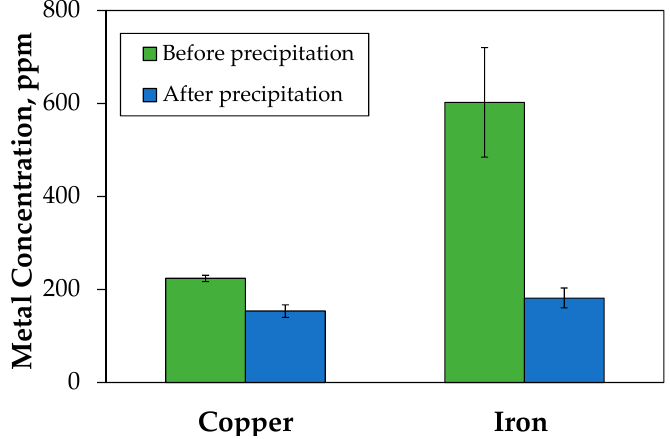
Figure 6. Effect of precipitation treatment on the removal of iron from PLS. Solution pH 4 after Figure 6. E ff ect of precipitation treatment on the removal of iron from PLS. Solution pH 4 precipitation. after